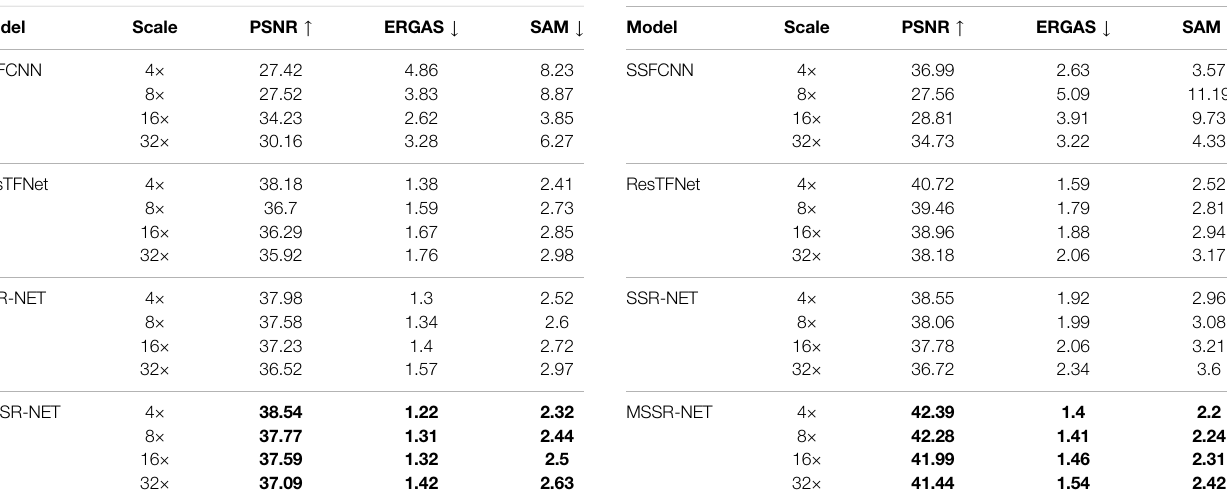
TABLE 7 | Quantitative results on Pavia University dataset. HR MSI is generated according to Type 2